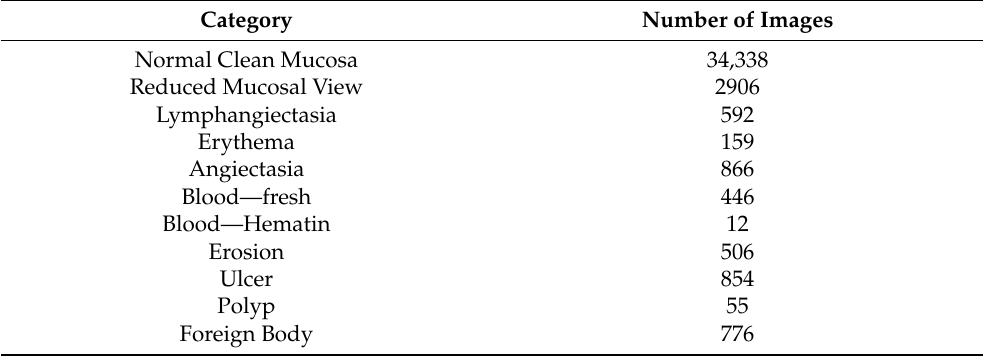
Table A1. Data distribution of Kvasir-Capsule dataset [27]. The eleven categories of this dataset show strong imbalances.